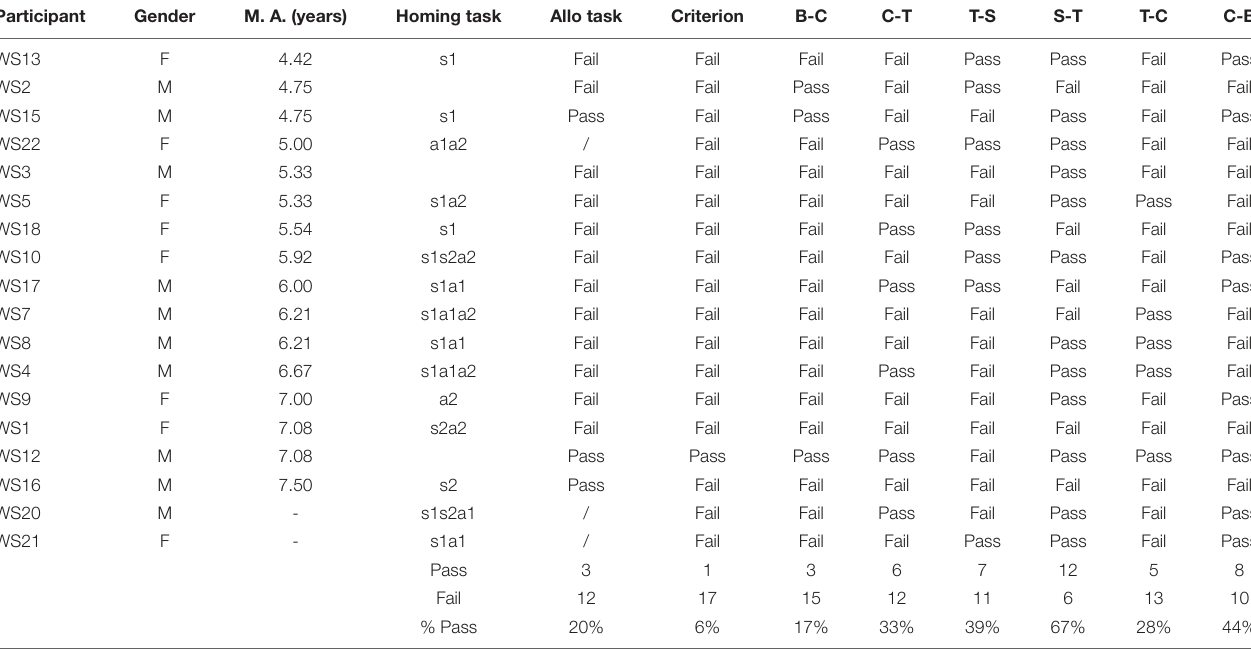
TABLE 8 | Individual performance of participants with WS for the never traveled trajectories of the cognitive mapping task. Participant Gender M. A. (years) Homing task Allo task Criterion B-C C-T T-S S-T T-C C-B WS13